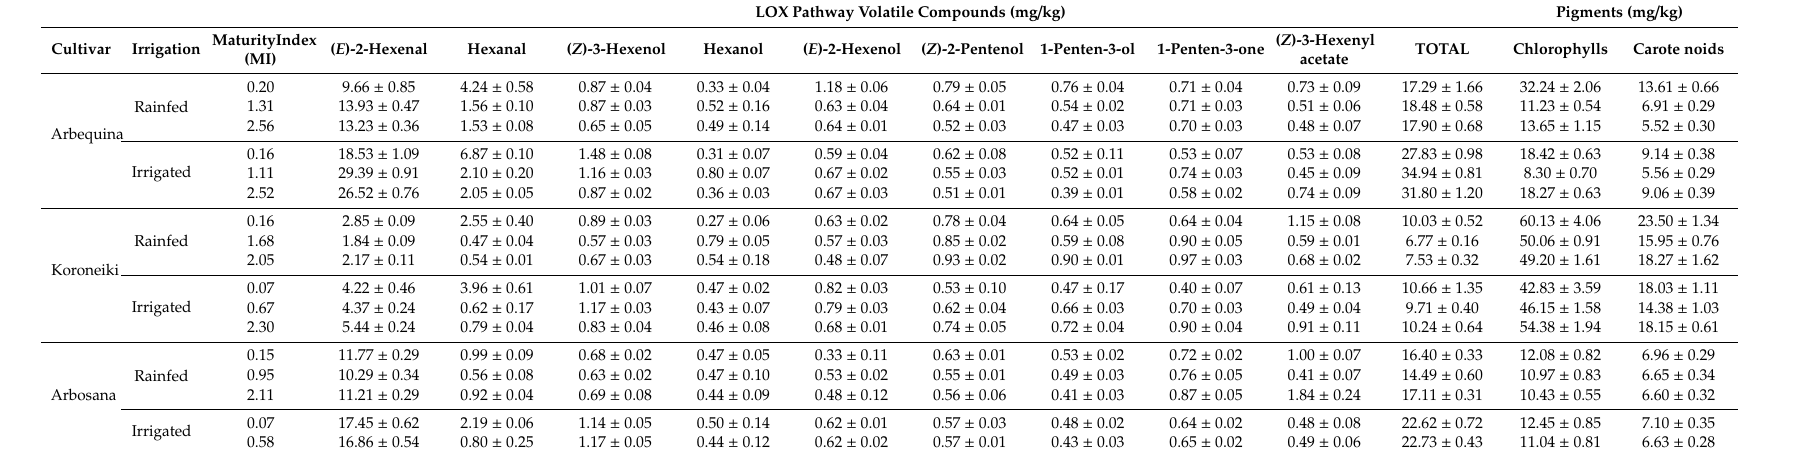
Table 4. Maximum value for volatile compounds and pigments response